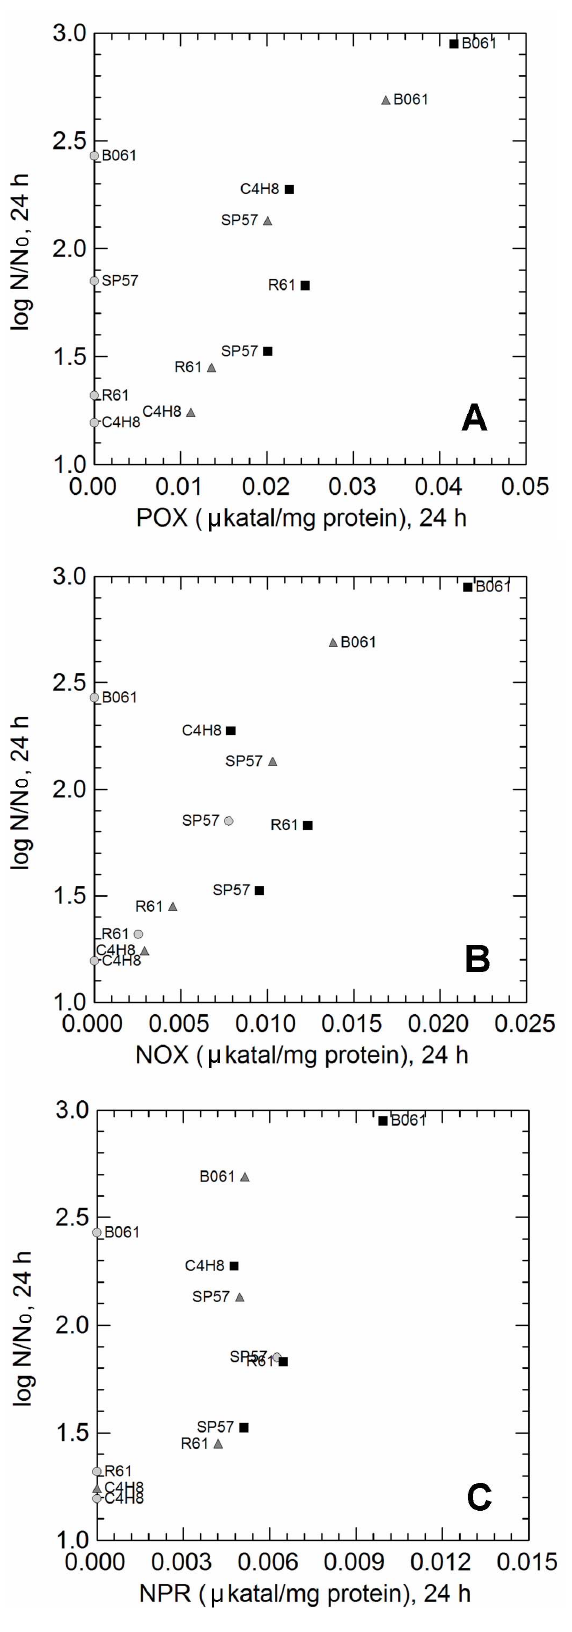
Figure 6. Correlations between cell numbers (log N/N 0 ) reached up 24 h of incubation (Y-axis) and activities ( m